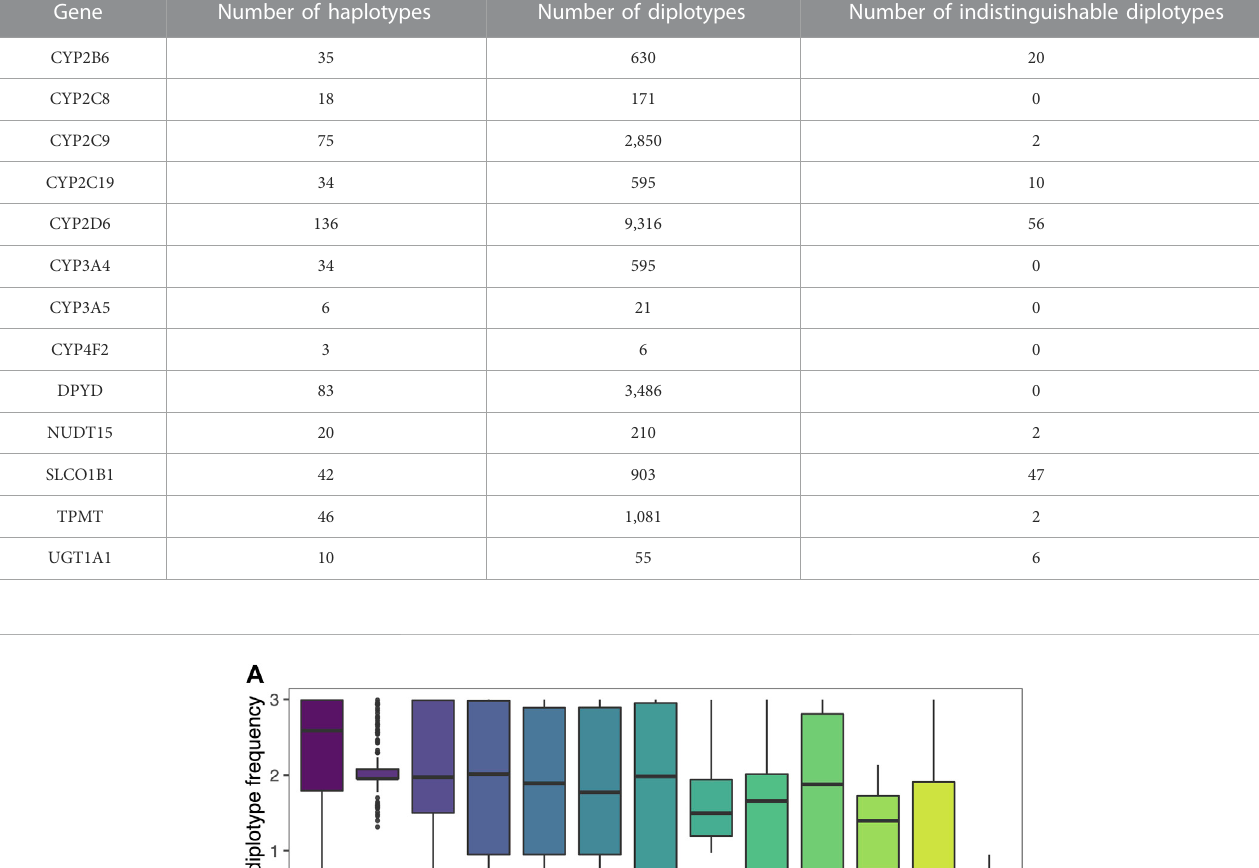
TABLE 1 Number of indistinguishable diplotypes for NGS-derived variants. Gene